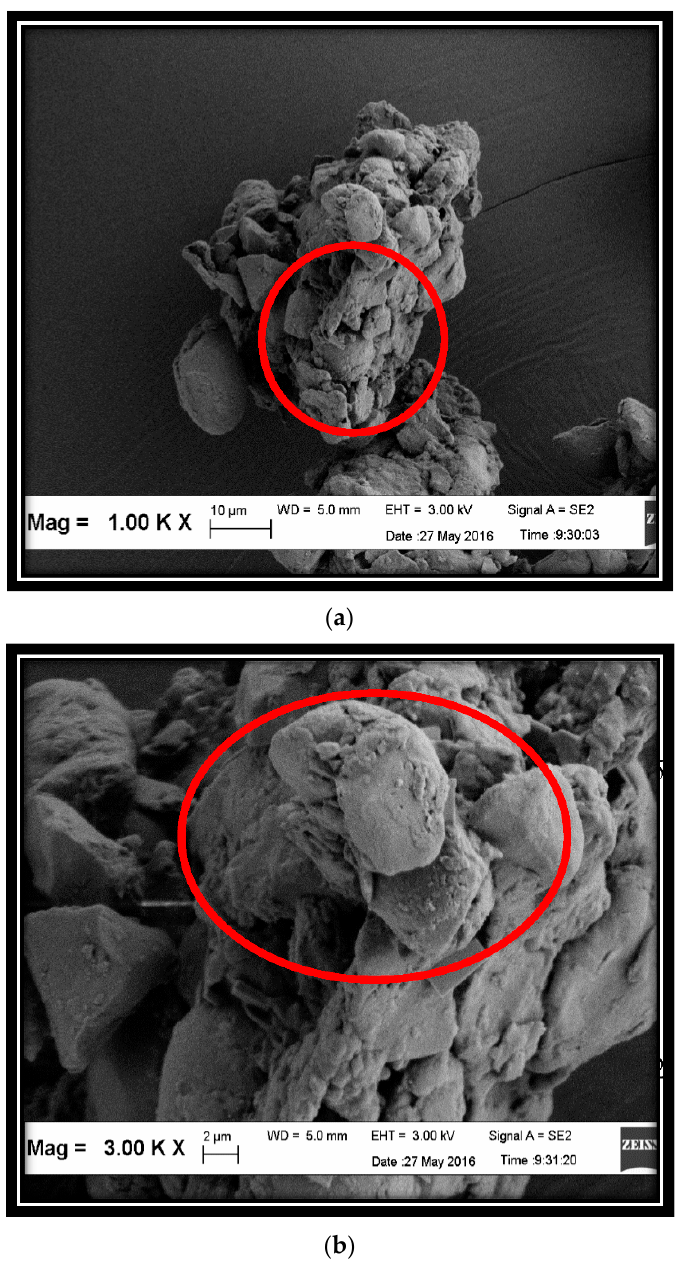
Figure 3. SEM images of LSP at ( a ) 1000 magnification ( b ) 3000 magnification.